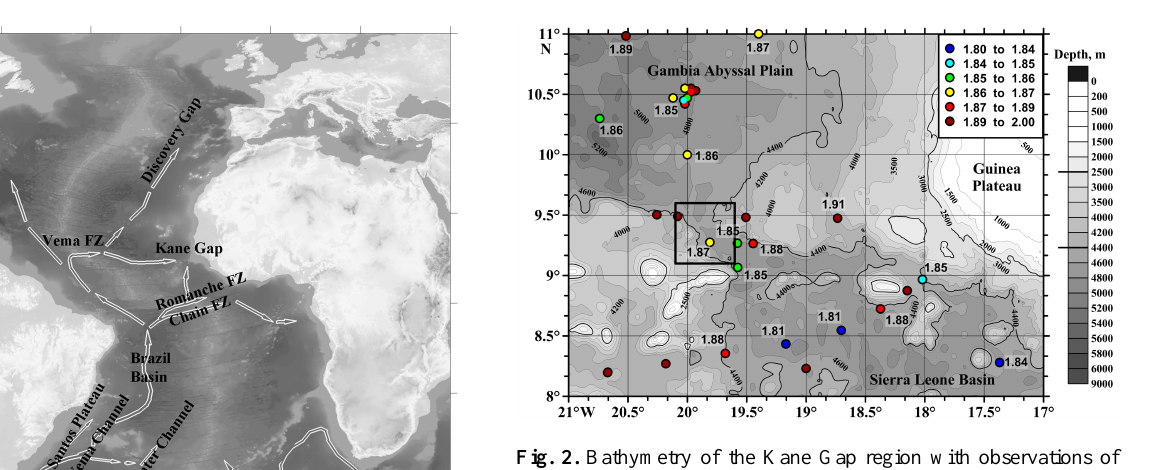
Fig. 2. Bathymetry of the Kane Gap region with observations of near-bottom potential temperature ( ◦ C) according to the WOD09 database. Historical stations are shown with dots of different color depending on the temperature (see notations in the inset; our study region is shown with a black square). Updated and adopted with modifications from Morozov et al.